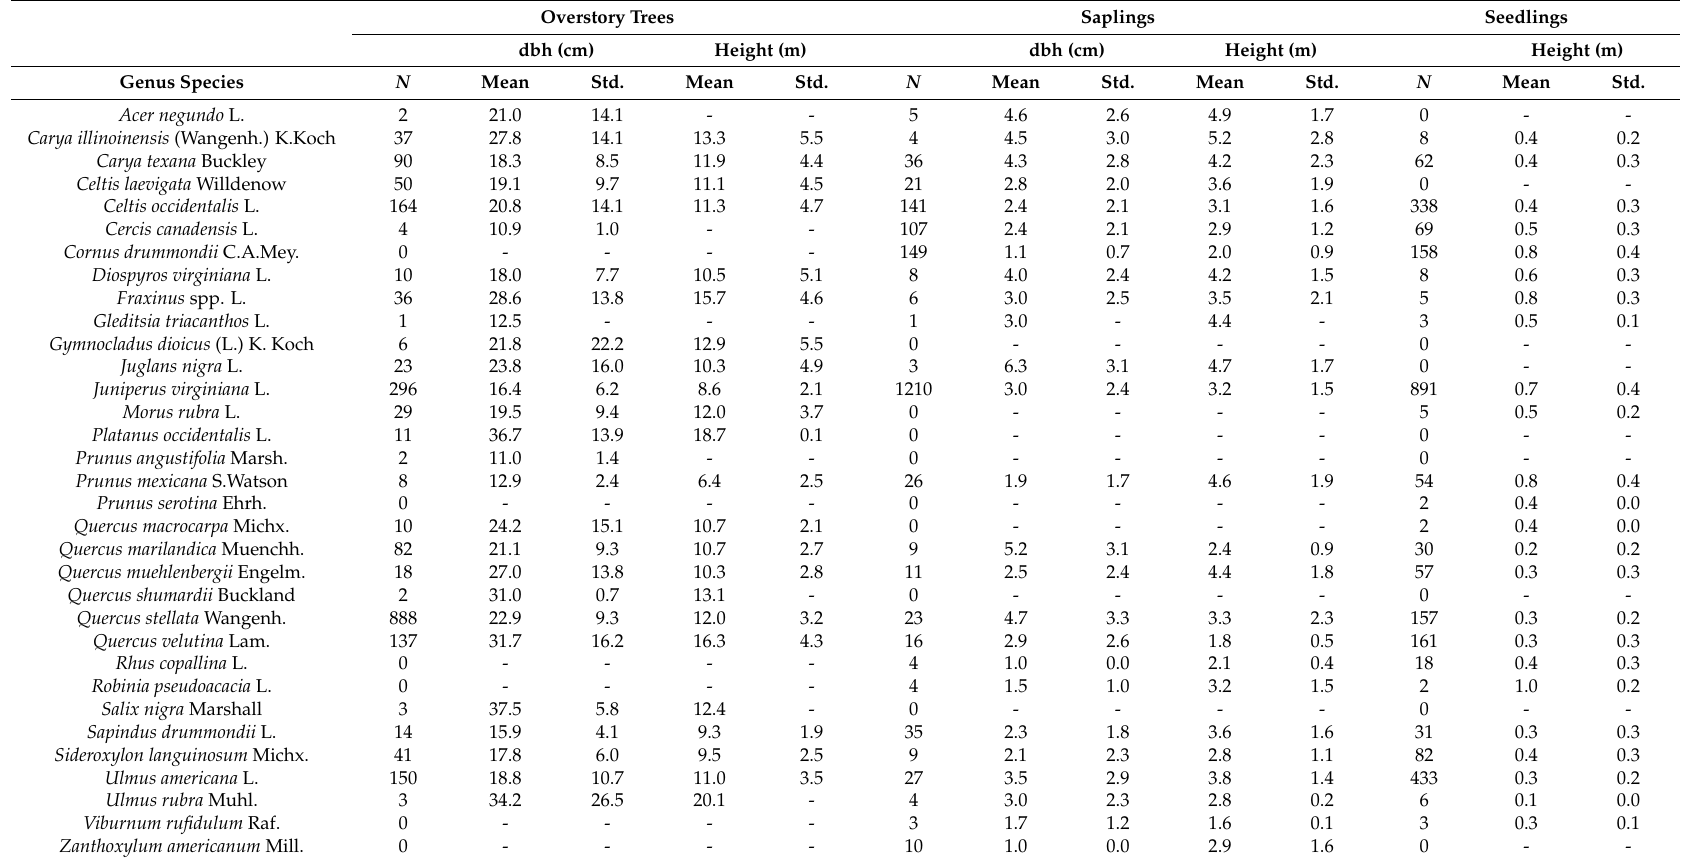
Table 1. Number encountered ( N ) and average dbh and height of trees (dbh > 10 cm), sapling (dbh 0.1 to 10 cm) and seedlings (shorter than 1.37 m) from 130 plots measured in Cross Timbers forests of north-central Oklahoma. Std. = standard deviation. Trees were measured in plots 0.04 ha in size (5.2 ha total). For hardwoods, saplings were measured in plots 0.004 ha in size (0.52 ha total) and seedlings in plots 0.001 ha in size (0.13 ha total). Juniperus virginiana L. overstory, saplings and seedlings were measured in the 0.04 ha plots (5.2 ha total). For seedlings, all Celtis spp. are lumped as Celtis occidentalis